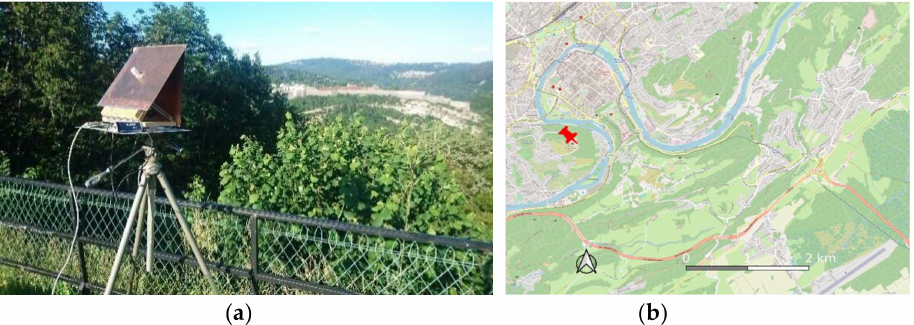
Figure 8. ( a ) Setup of the experiment conducted in Besançon, France, at the Fort Chaudanne location and ( b ) the aerial picture of the observed scene with the experiment site indicated by the red nail.